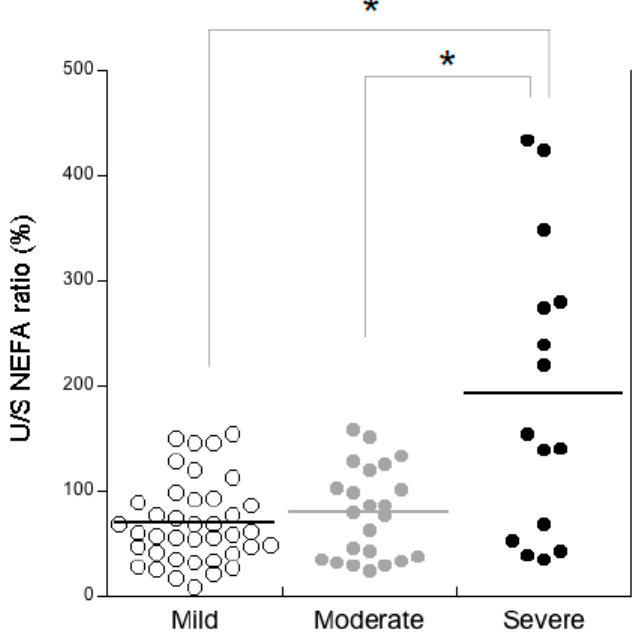
Figure 3. Comparison of the salivary unsaturated/saturated NEFA ratio (U/S NEFA ratio) among CF patients with mild ( n = 31), moderate ( n = 20) and severe ( n = 15) lung disease. * p < 0.0001; severe versus mild and moderate, ANOVA.